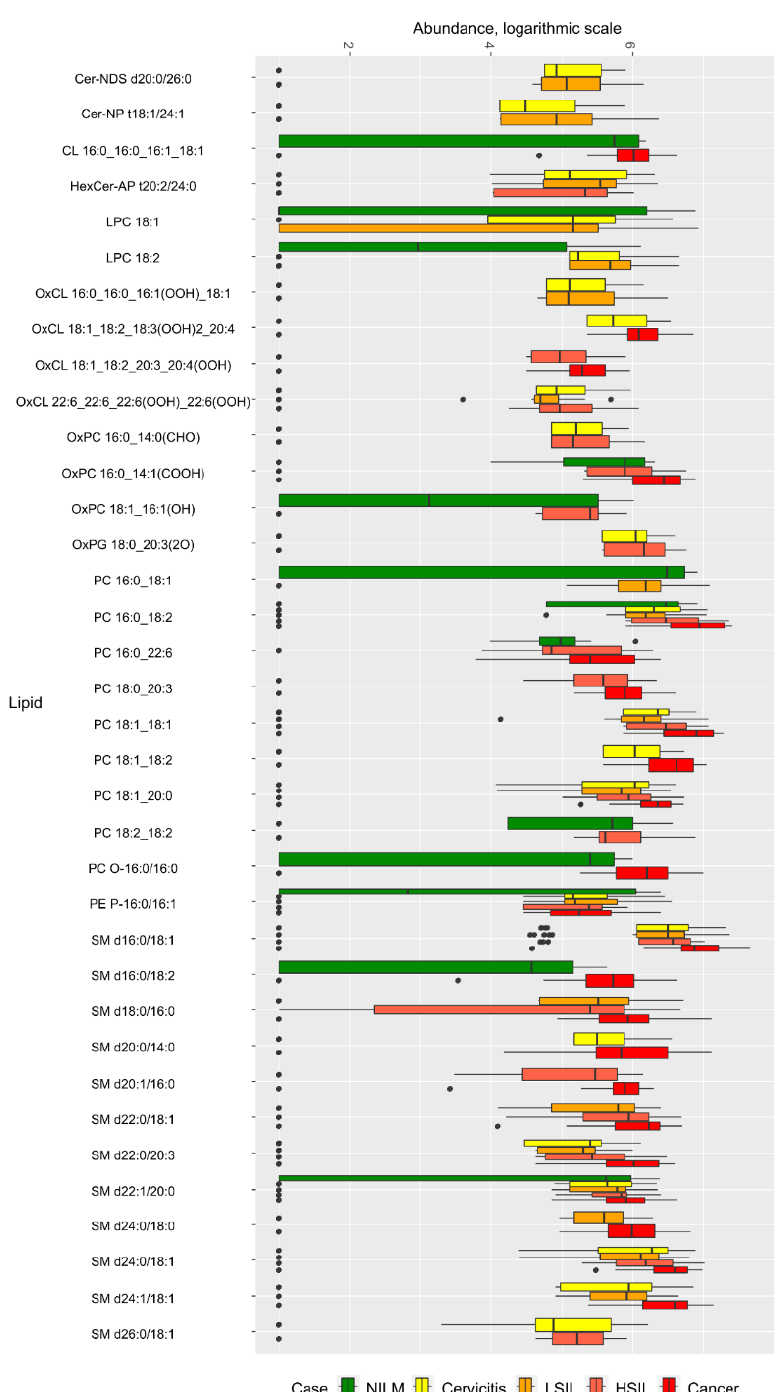
Figure 3. Box plot of lipid levels included in the discriminative models in the negative ion mode. Cer-NDS — non-hydroxy fatty acid dihydrosphingosineceramide; Cer-NP — non-hydroxy fatty acid phytosphingosineceramide; CL — cardiolipin; HexCer-AP — alpha-hydoxy fatty acid phytosphingosineglucosylceramide; LPC — lysophosphatidylcholine; OxCL — oxidized cardiolipin; OxPC — oxidized phosphatidylcholine; PC — phosphatidylcholine; PC O — plasmanylphosphatidylcholine; PE P – plasmenylphosphatidylethanolamine; SM — sphingomyelin.